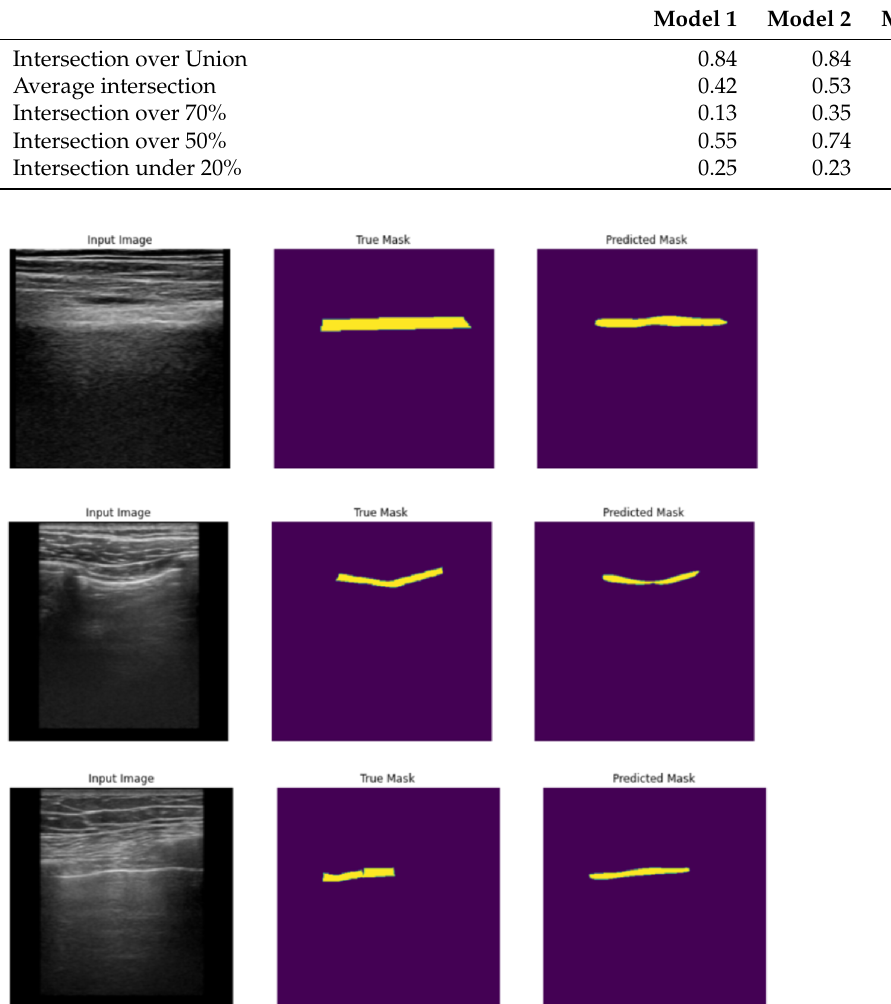
Figure 10. Examples of original frames (left column), true masks extracted from original frames (middle column), and predicted masks for pleura segmentation (right